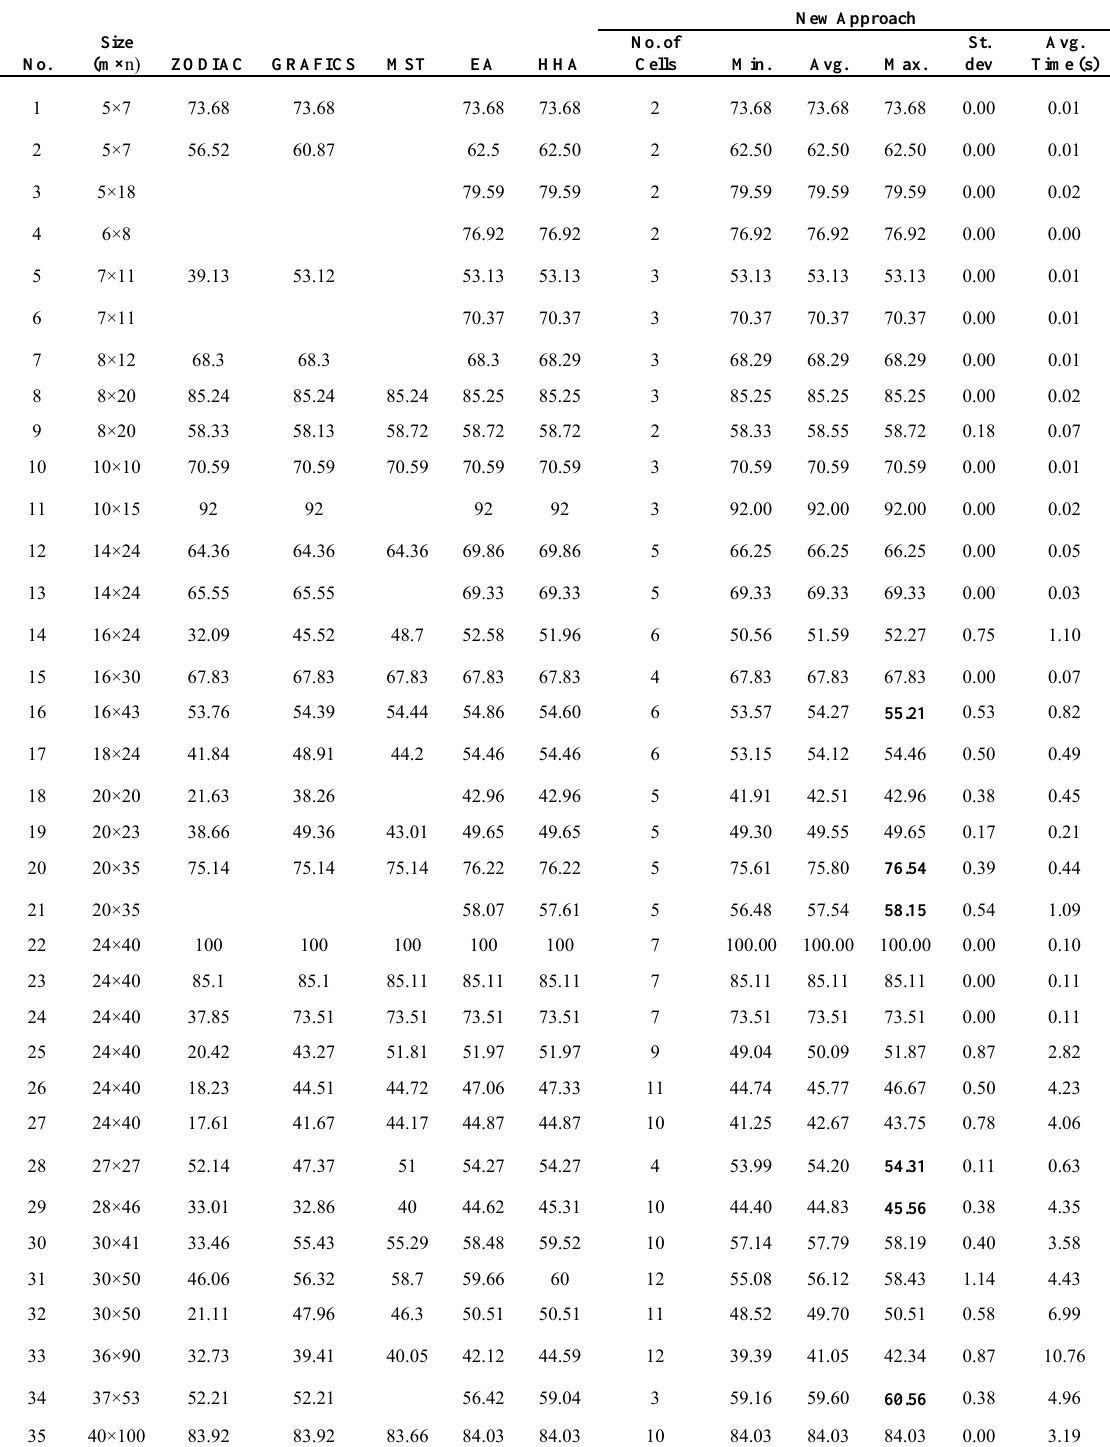
Table 3. Results in the case where singletons are not